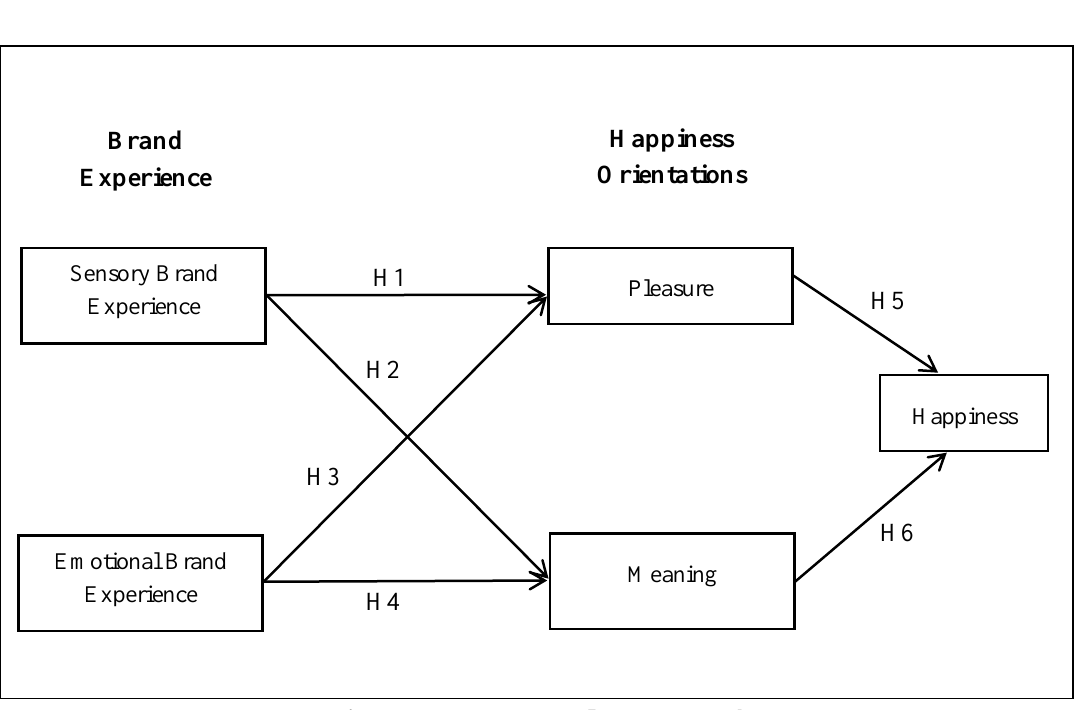
Figure.1. Conceptual